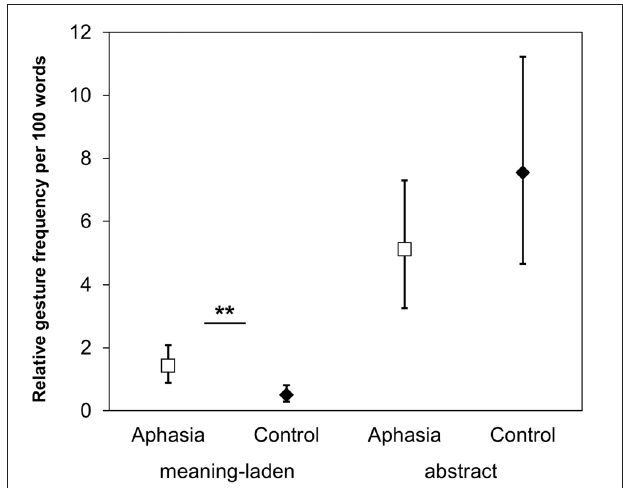
FIGURE 4 | Gesture production. The relative gesture frequency per 100 words illustrating the Gesture Category × Group interaction. Asterisks denote the significant post hoc comparison ( ∗∗ p < 0.01). Error bars represent the 95% confidence intervals around the estimated